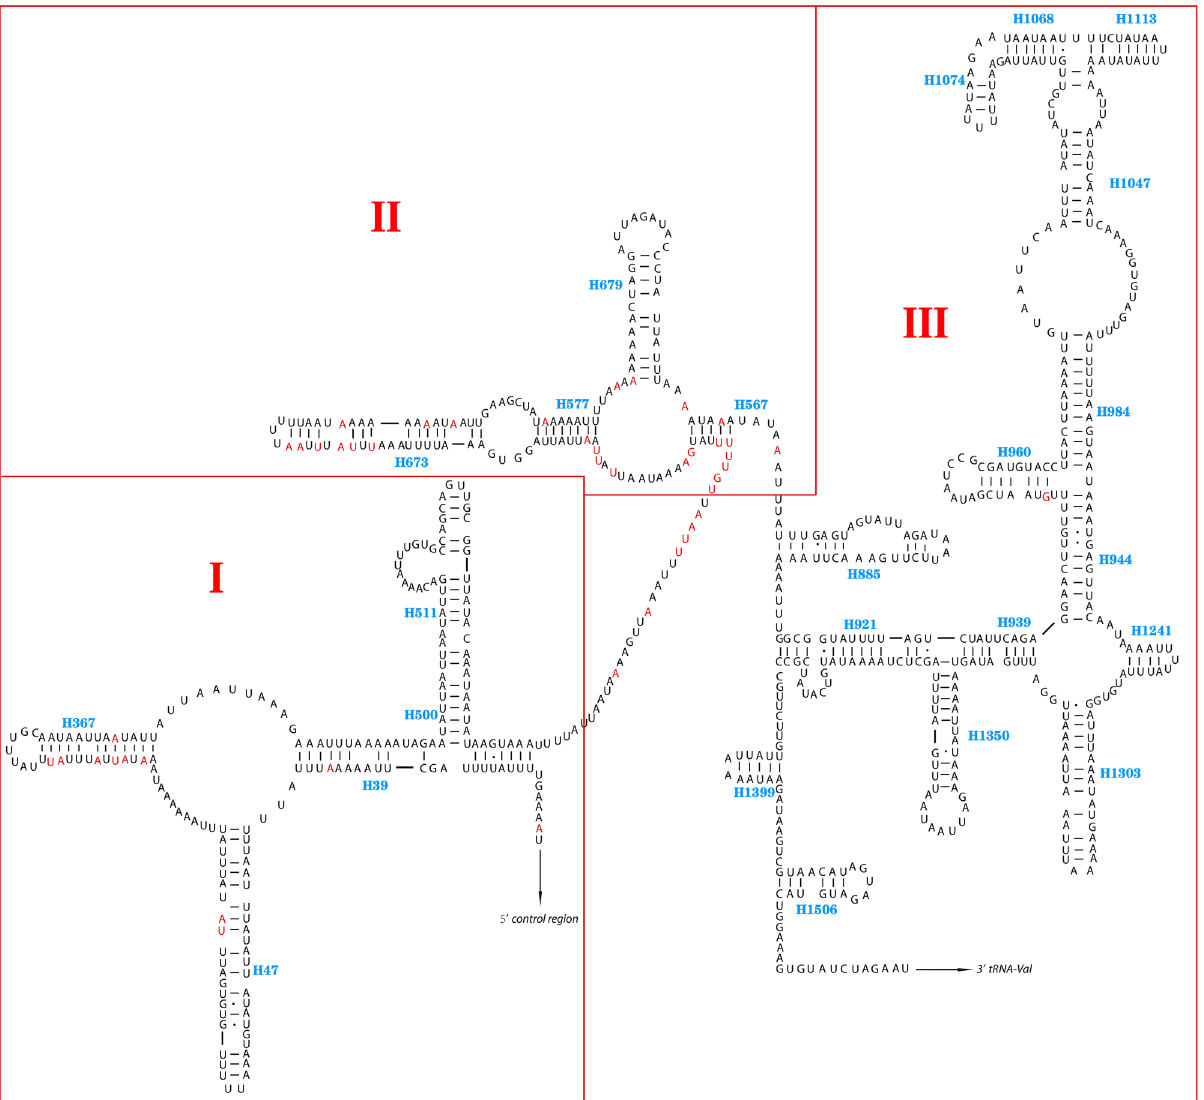
Figure 6. Predicted secondary structure for 12S rRNA of E. sp. The red color indicates the variation nucleotide sites in four species. The names of helices showed in blue “H + numbers.” Areas surrounded by red lines indicate different domains and are respectively numbered I, II, and III in red as in other insects. The image was predicted by ClustalX 1.81 (http:// www. hgmp. mrc. ac. uk/ Regis tered/ Option/ clust alx. html) and RNA Structure 5.2 (http:// rna. urmc. roche ster. edu/ RNAst ructu re. html), drawing with Adobe Illustrator